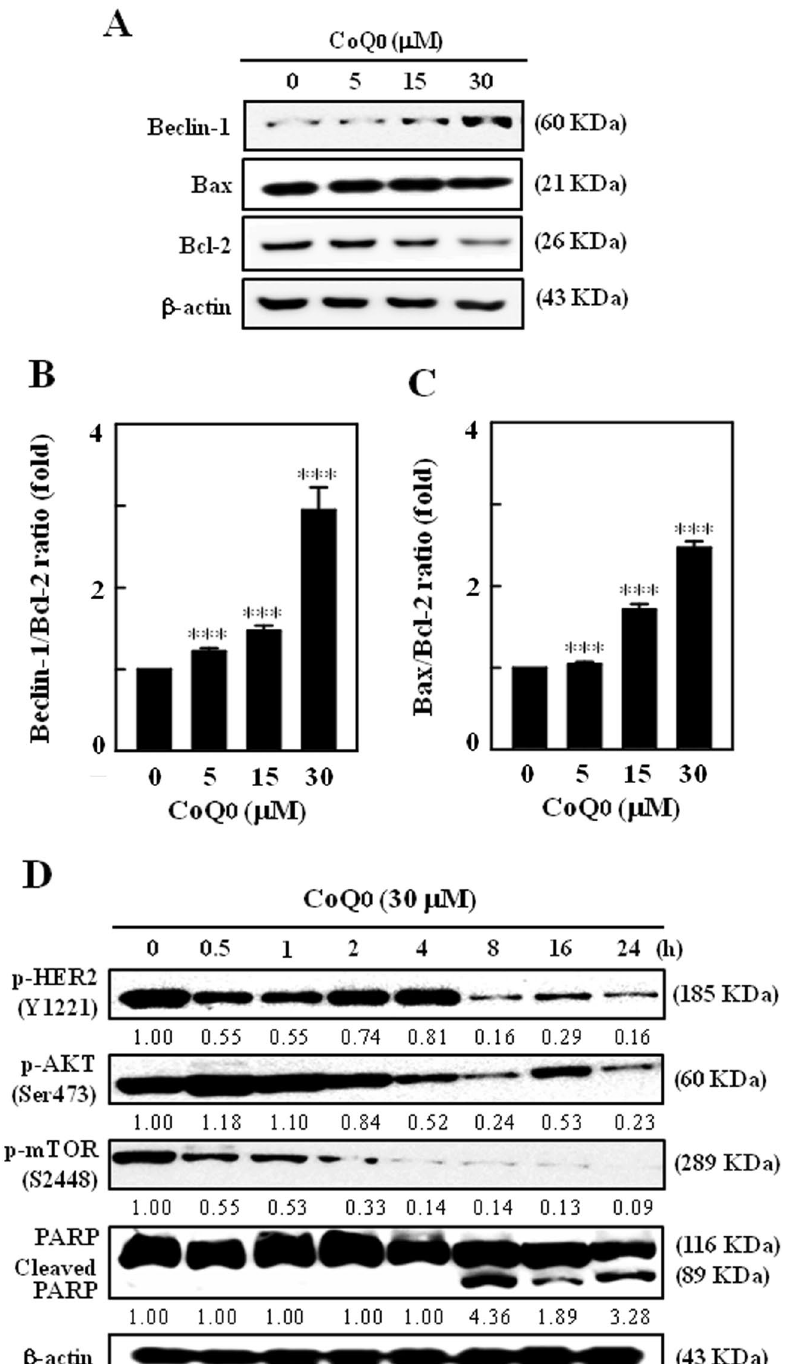
Figure 6. CoQ 0 increases Beclin-1/Bcl-2 and Bax/Bcl-2 ratios, and inhibits HER-2/ neu /AKT/mTOR signalling in SKOV-3 cells. (A) Dose-dependent effect of CoQ 0 (0–30 µ M, 24 h) on changes in Beclin-1, Bax and Bcl-2 proteins were determined by Western blot. Relative changes in the ratio of (B) Beclin-1/Bcl-2 and (C) Bax/Bcl-2 in accordance to dose were quantified by commercially available software, and presented as a histogram, control representing as 1.0 fold. Results expressed as mean ± SD of three independent assays (n = 3), and significant at *** p < 0.001 compared with untreated control cells. (D) Time-dependent effect of CoQ 0 (0–24 h, 30 µ M) on phosphorylation of HER-2/ neu (Y1221), AKT (Ser473) and mTOR (S2448), and cleavage of PARP were determined by Western blot. Results expressed as mean ± SD of two independent assays (n =